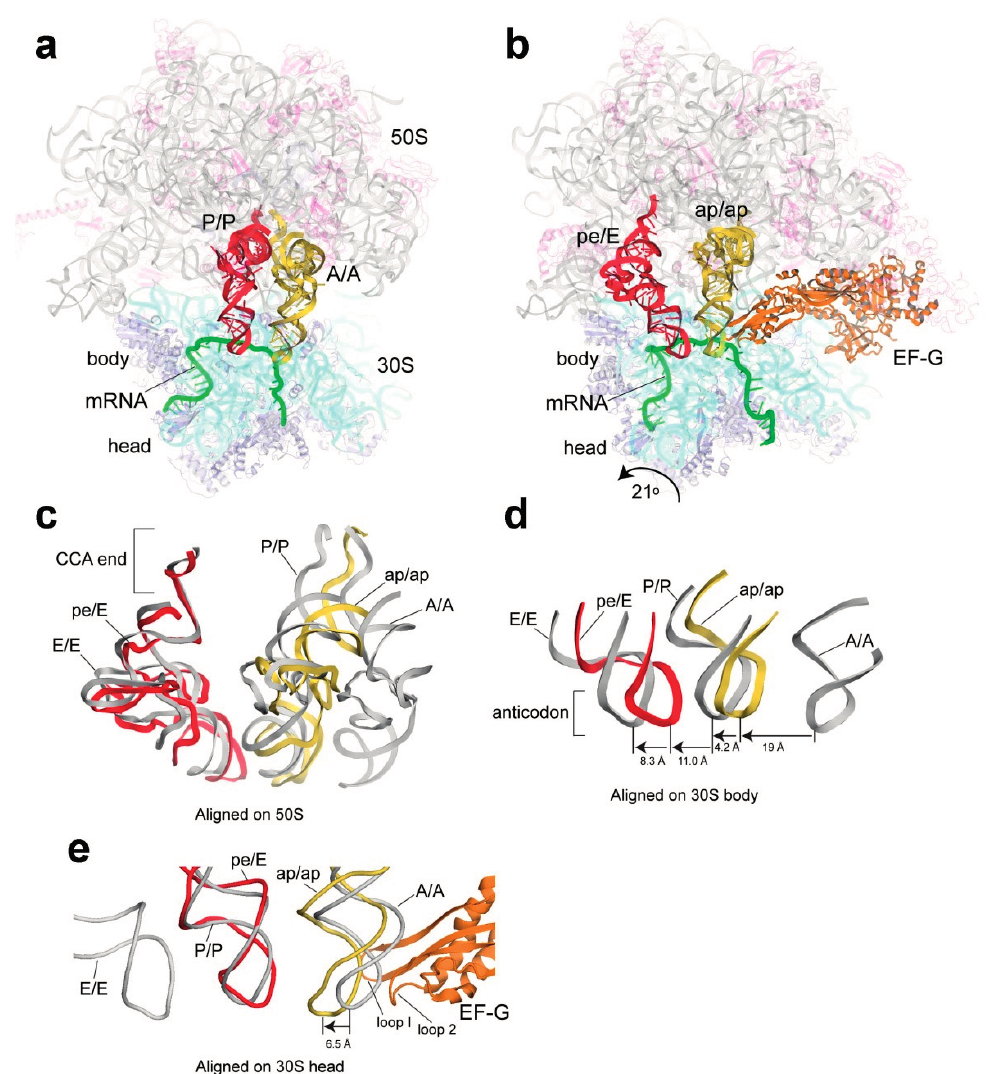
Figure 8. EF-G mediated mRNA-tRNA translocation intermediate. ( a ) Classic state pre-translocational complex (PDB 4V6F [188]); ( b ) Translocation intermediate in the presence of EF-G, bearing chimeric hybrid ap/ap and pe/E state tRNAs (lower-case letters imply that the corresponding tRNA is bound in a chimeric configuration, i.e. , halfway through the path from one canonical site to the next). Comparison of tRNA positions in classic and intermediate states after alignment of ( c ) 50S subunits; ( d ) 30S subunit bodies or ( e ) 30S subunit heads. (Figure adapted from [189], Copyright 2014 Am. Assoc. Adv.